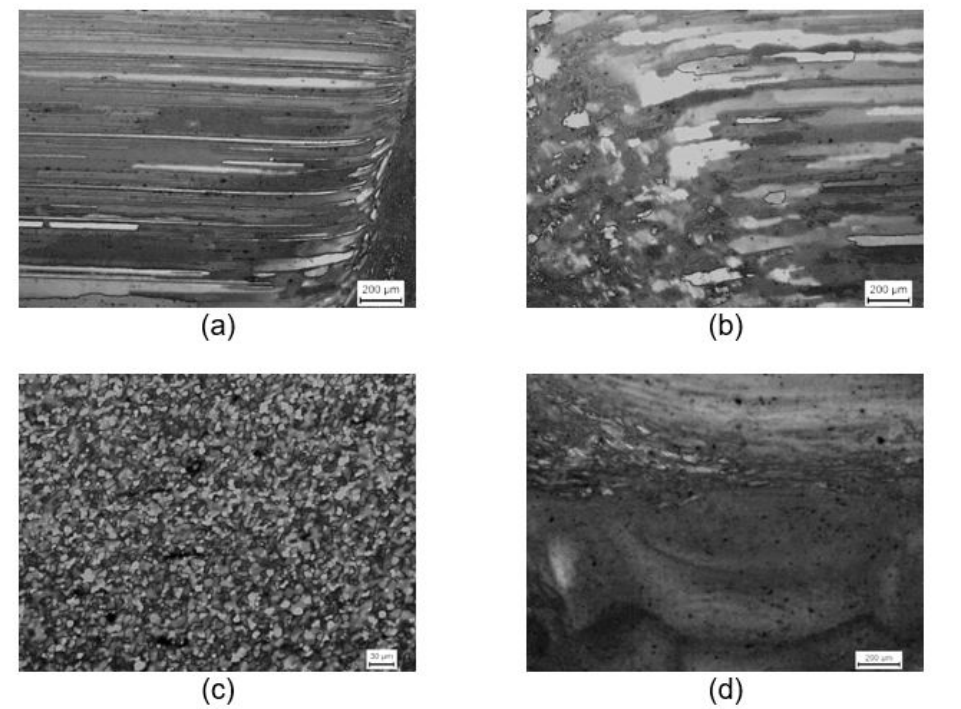
Figure 7. Higher magnification of regions marked as A, B, C and D as in Figure 4 , showing different microstructural features in the welding area.